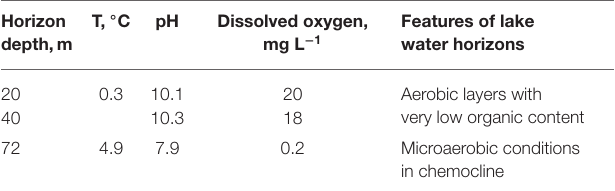
TABLE 1 | Some characteristics of water sampling horizons from the Lake Untersee (Andersen et al., 2011). Horizon T, ◦ depth,m